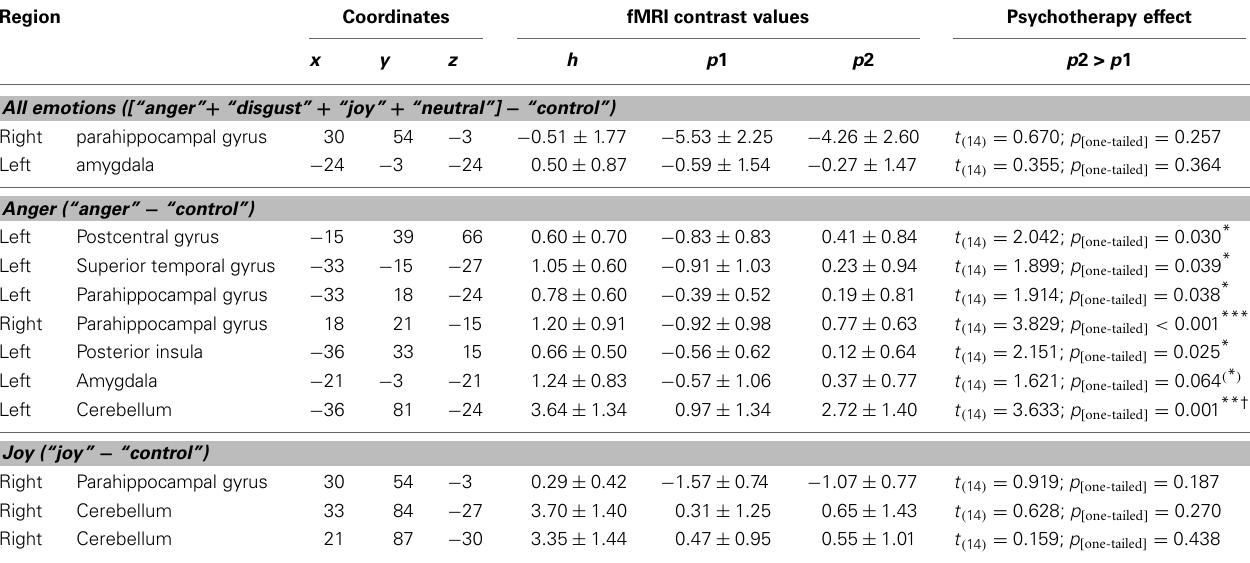
Table 2 | Effect of psychotherapy on hemodynamic responses—ROI based approach. Region Coordinates fMRI contrast